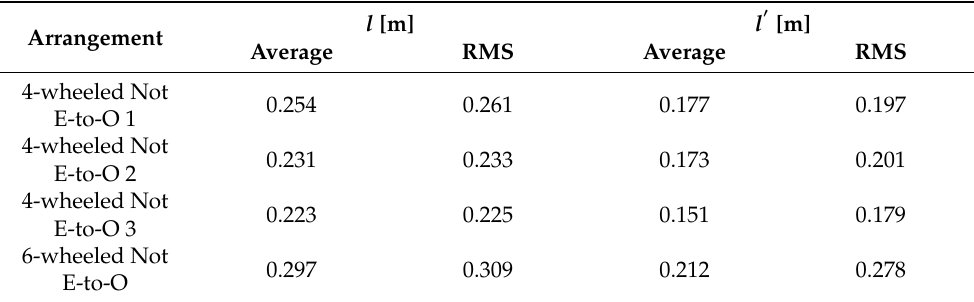
Table 6. Average and root-mean-square of the distance l of the wheel from the origin and the distance l (cid:48) between the wheel’s resulting velocity vector and the origin in each